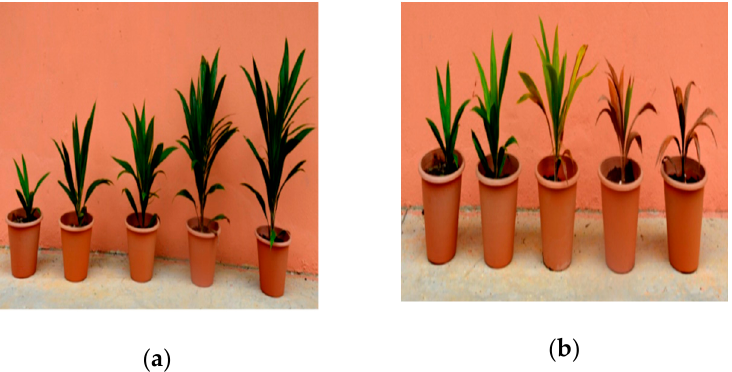
Figure 1. Oil palm seedlings and basal stem rot disease progression: Three-month-old oil palm seedlings (DuraXPsifera) challenged by pathogenic Ganoderma boninense . ( a ) Uninfected seedlings (control); ( b ) infected seedlings at one-to-five-month post-inoculation (mpi). Pots arranged from the most left represent one mpi and increases thereafter.